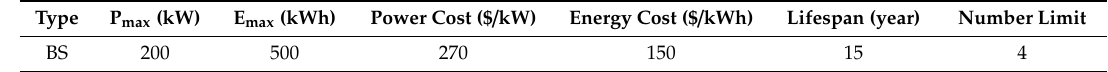
Table 13. Candidate Buses for DER Integration. Table 12. Technical Parameters of BSs.